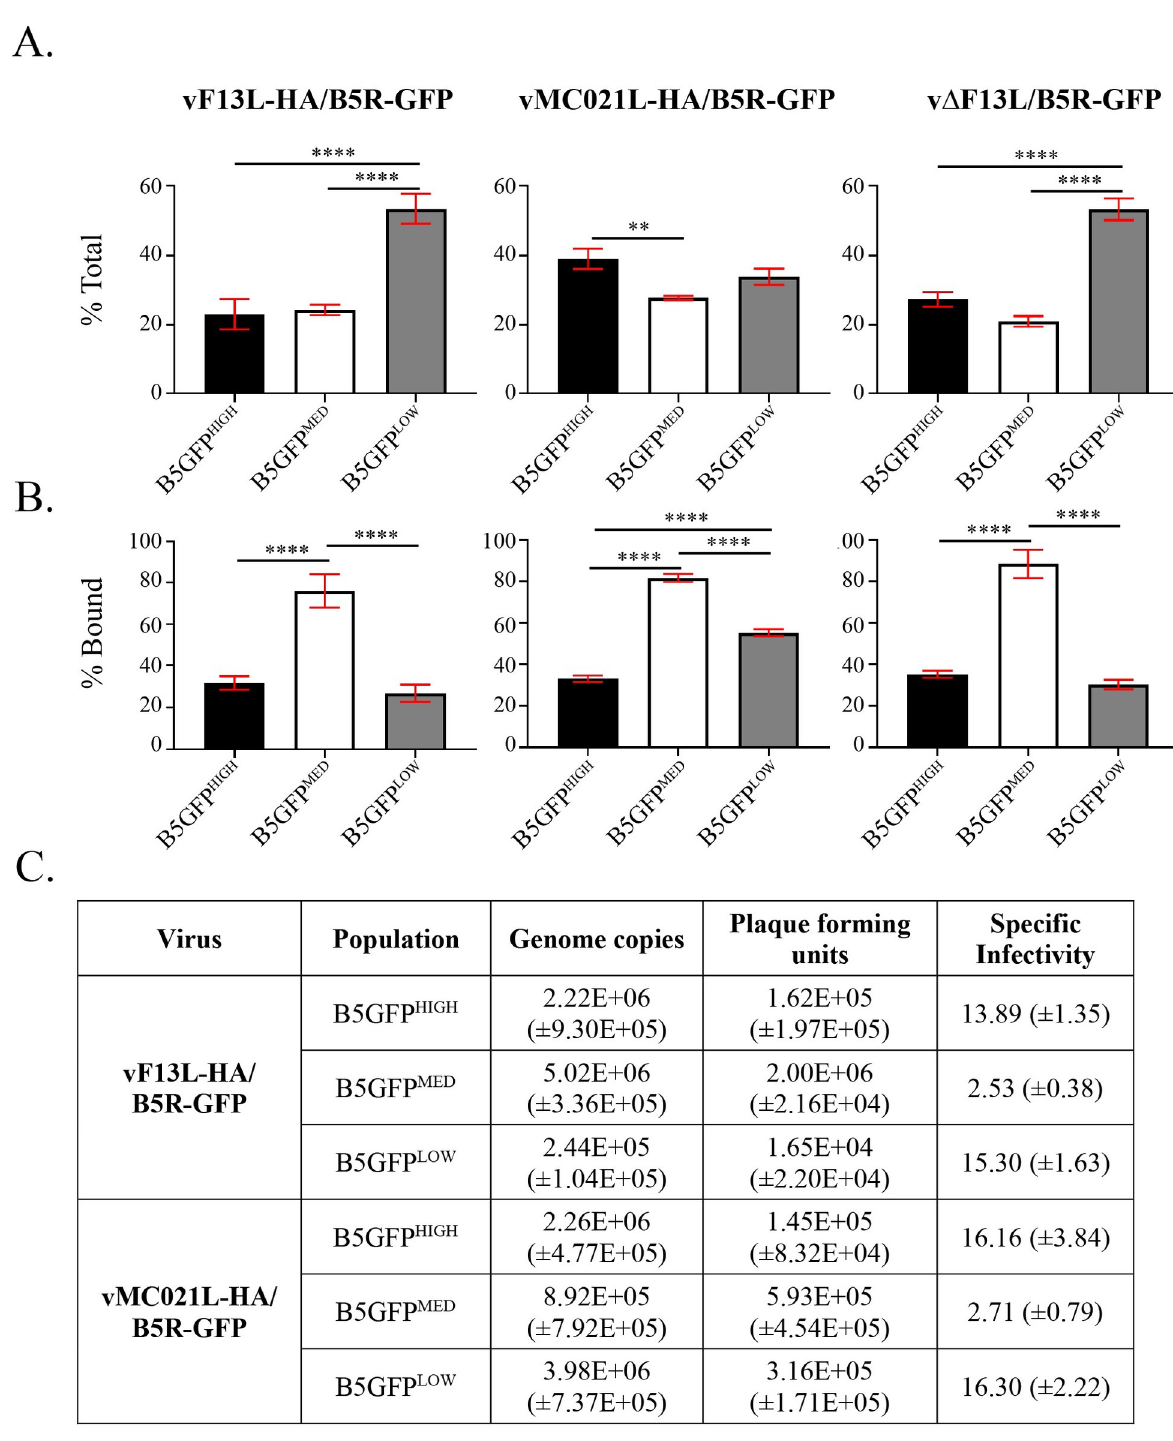
PLOS Pathogens| https://doi.org/10.1371/journal.ppat.1010177 December 28,